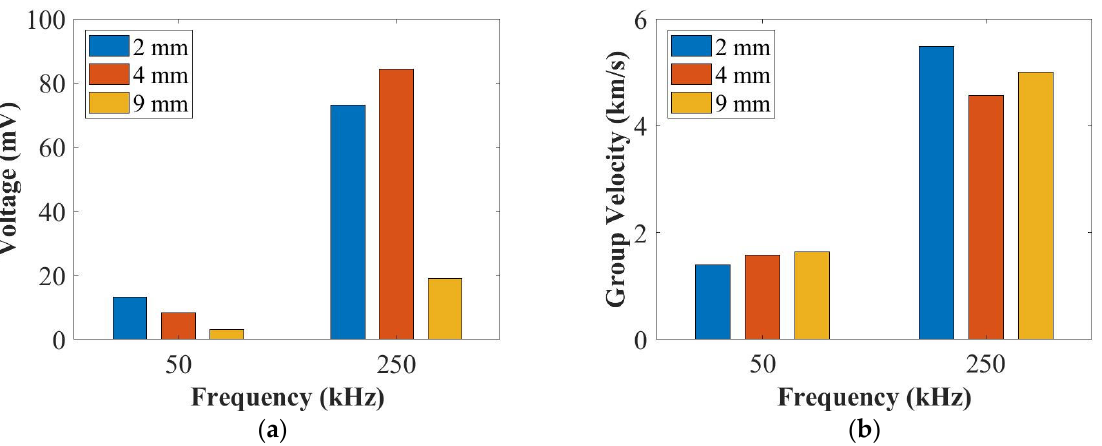
Figure 6. The summary of the amplitudes ( a ) and the group velocities ( b ) of UGWs for the panel thicknesses of 2 mm, 4 mm and 9 mm at 50 kHz and 250 kHz.